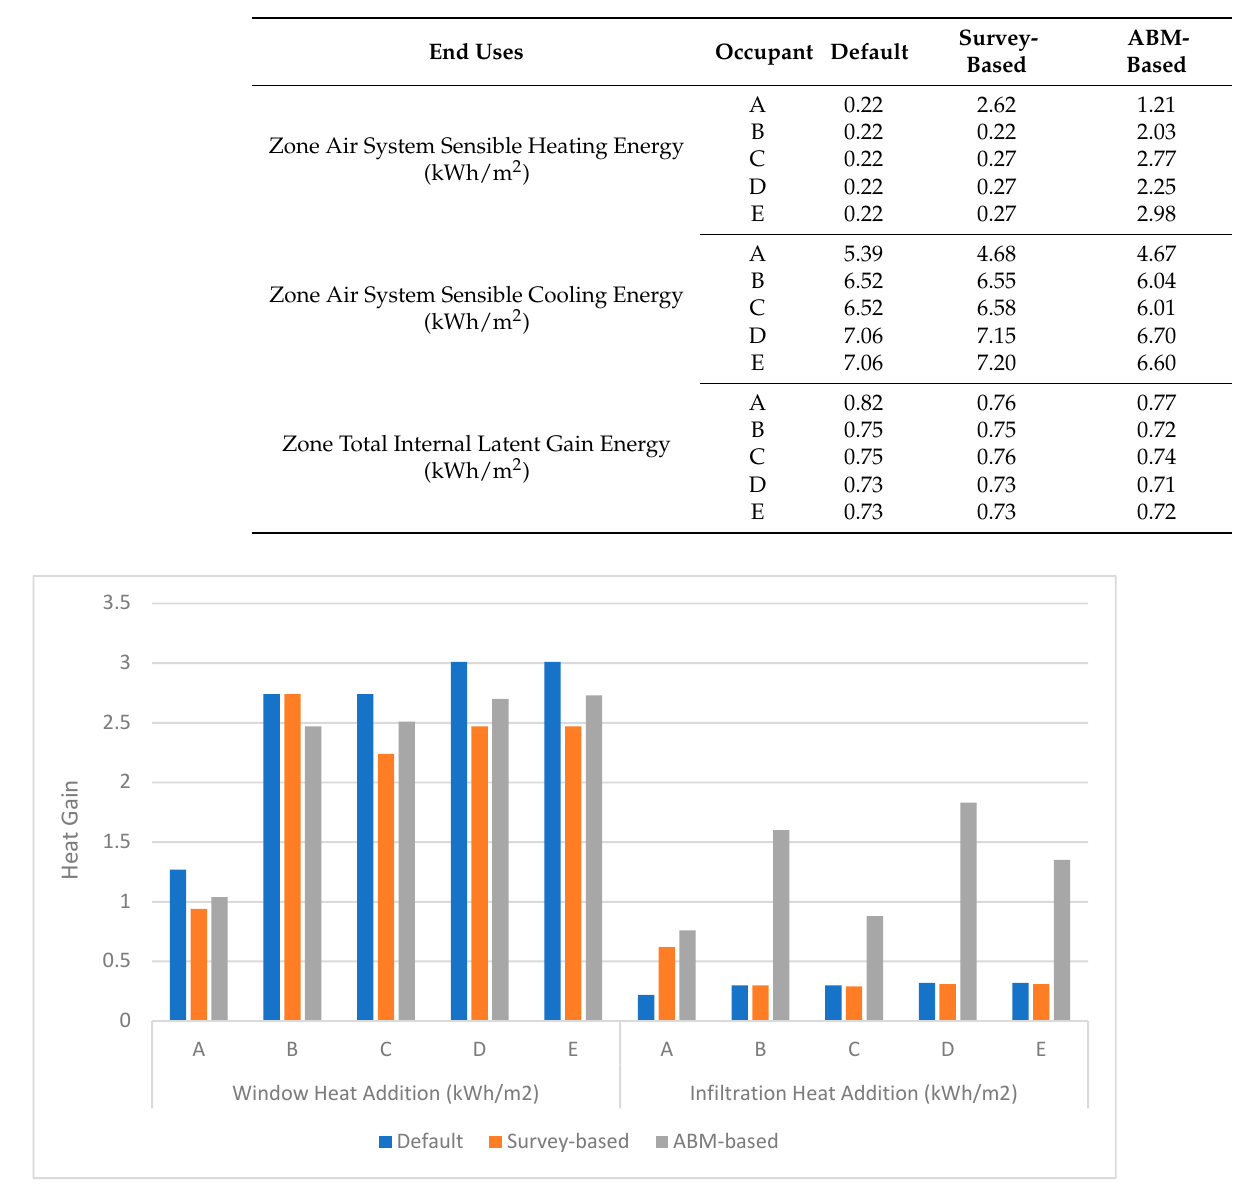
Table 4. Zone level energy–related data.